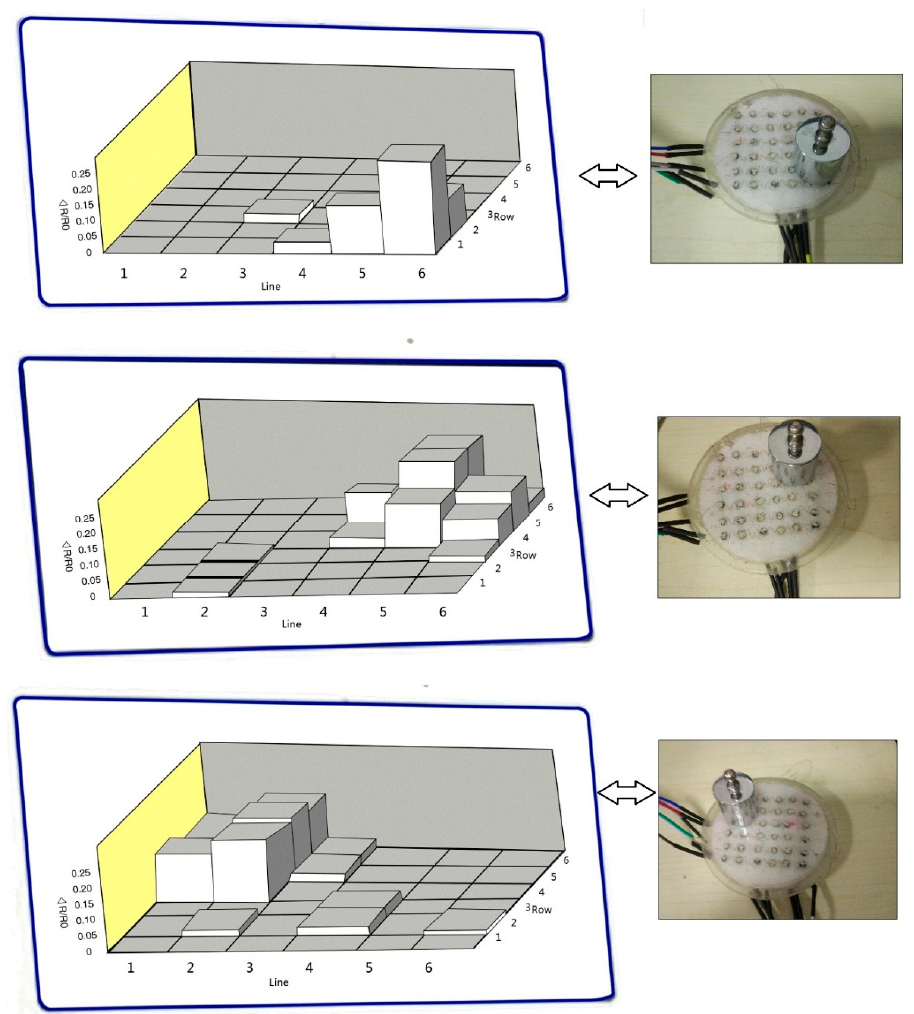
Figure 9. A sensor array with the weight placed on the surface to detect the different identifiable locations. The 100 g cylindrical standard weight was used to provide applied loading in the testing, shown in the inset.